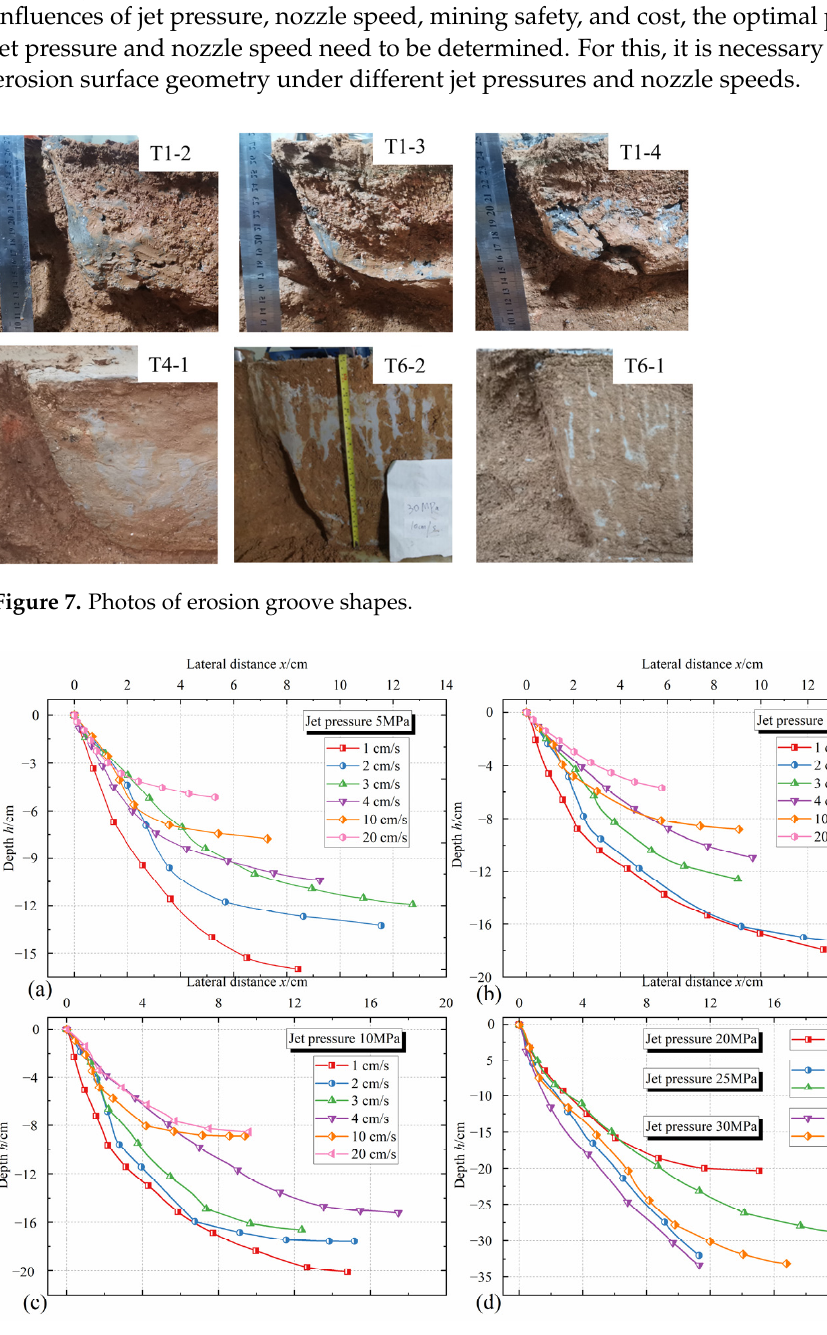
Figure 7. Photos of erosion groove shapes.